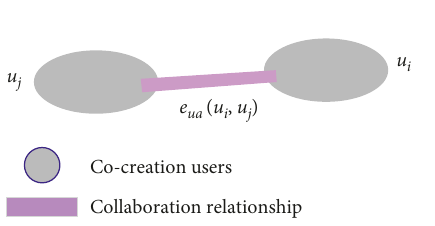
Figure 4: Co-creation user collaboration network.